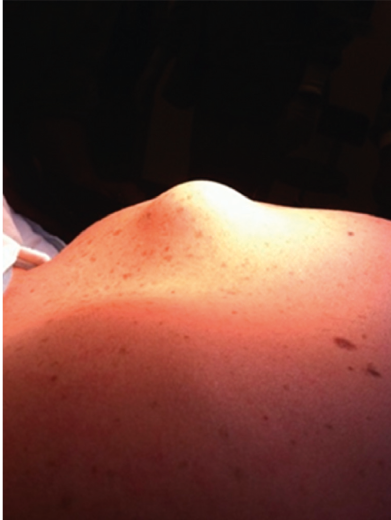
Figure 1: Nonmobile 4cm mass at the posterior aspect of the scapula.